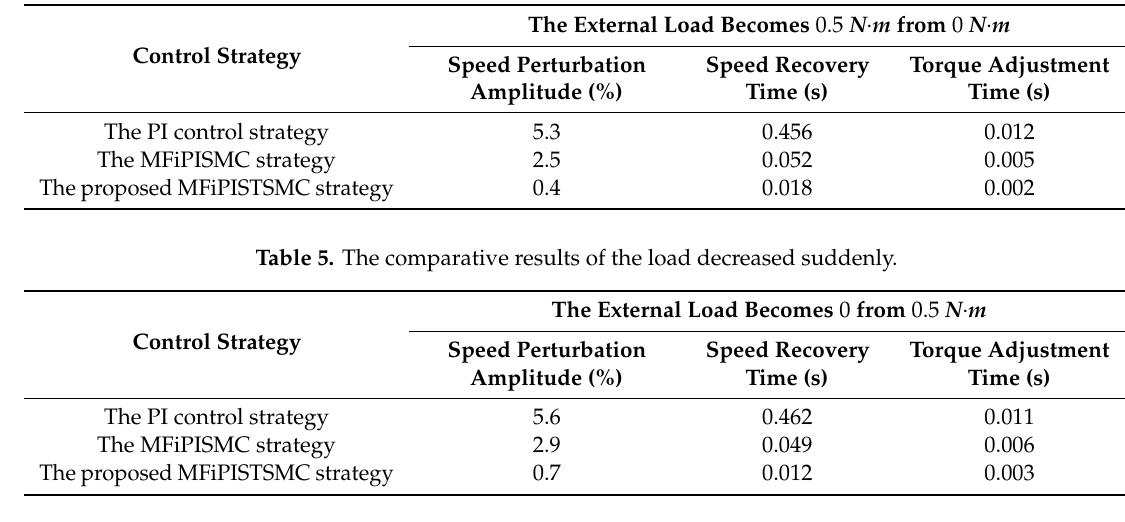
Table 4. The comparative results of the load increased suddenly.